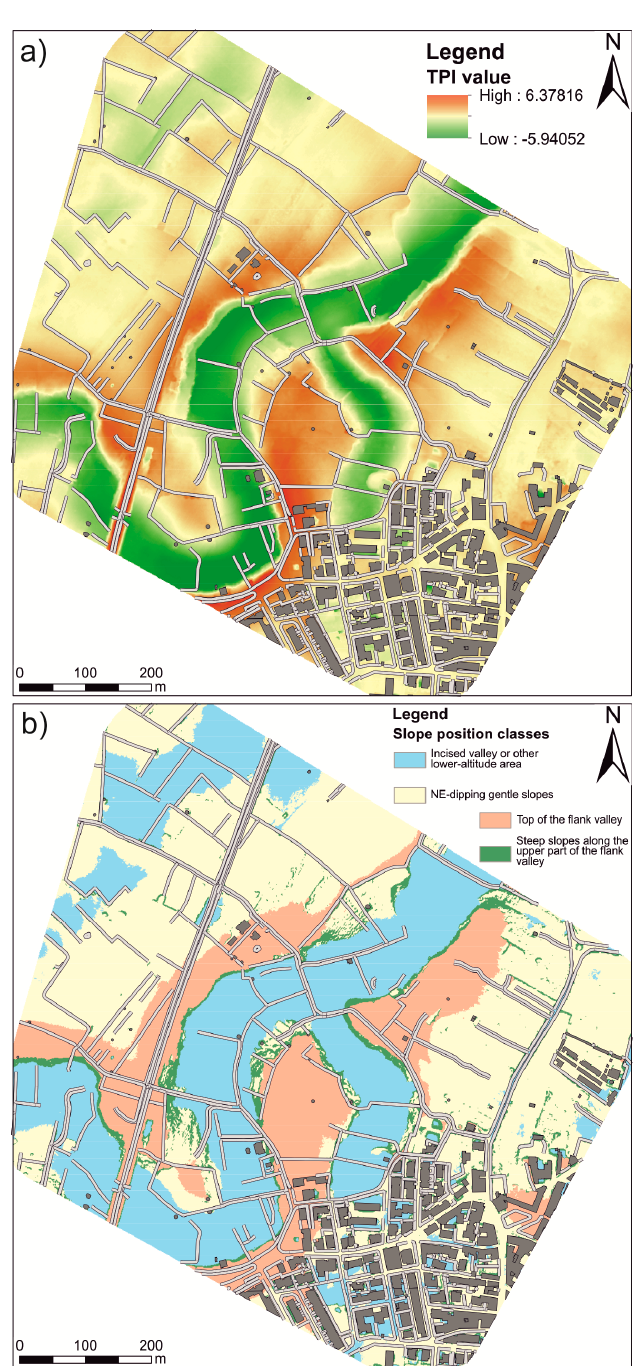
Figure 8. ( a ) Topographical position index (TPI)-based on a high-resolution DSM (1 m per cell). The map allowed us to distinguish between depressed area (in green) and top areas separated by lower elevation areas by steeper slopes (red tones of the graduated value scale). This map allowed us to bound the floodplain of this sector of Lama Lamasinata. Light gray and gray colours correspond to the roads and buildings, respectively. ( b ) Four category slope position map of the study area with the relative interpretation in terms of landform unit. Threshold values of the TPI values were − 0.2 and 0.8 whereas slope threshold was 5 degree.